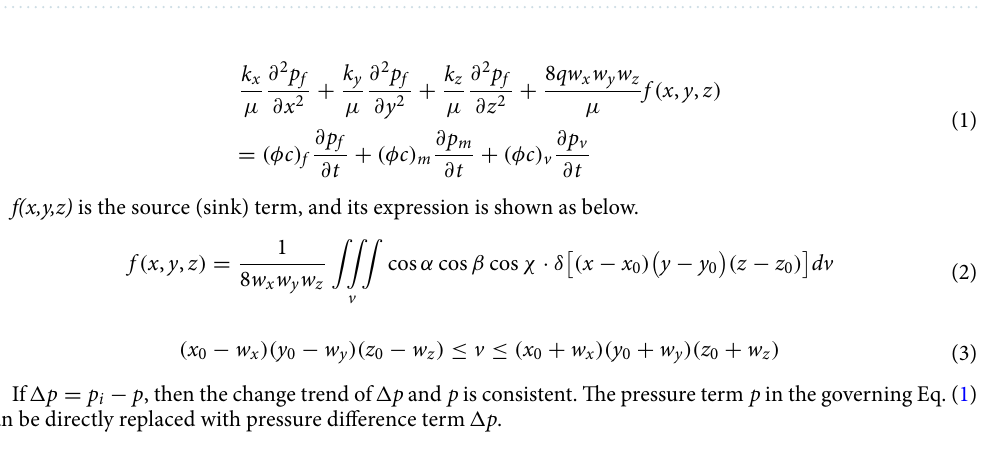
Figure 3. Simplified diagram of fluid